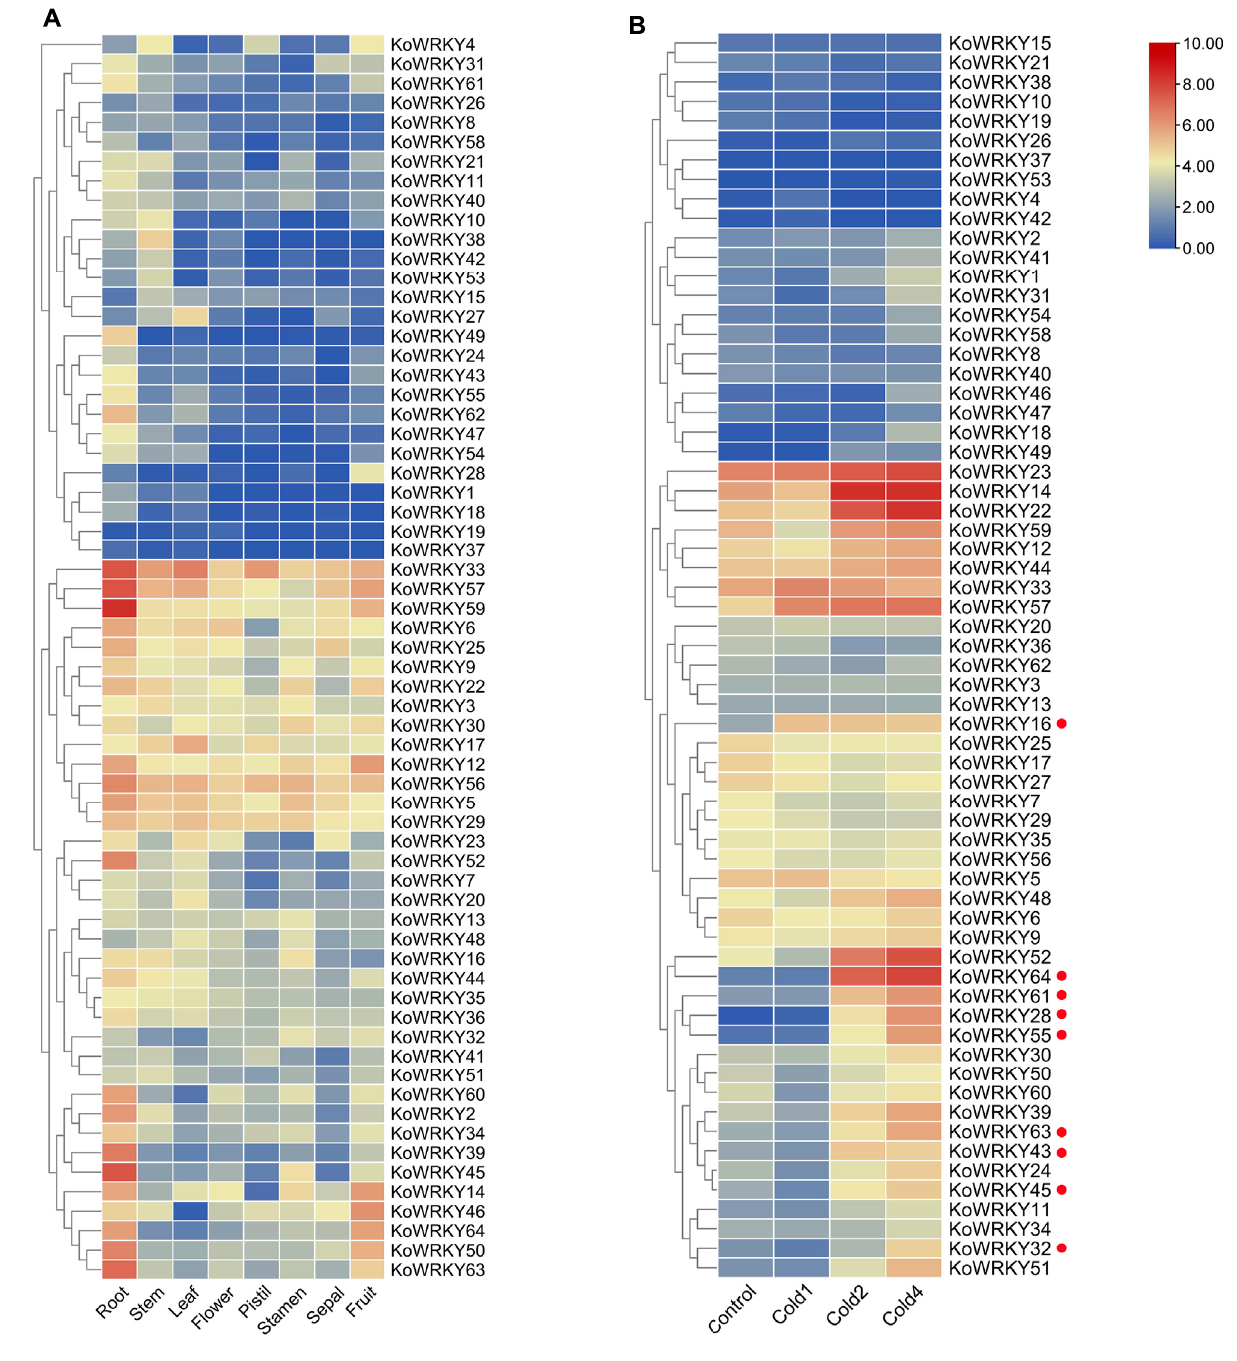
Frontiers in Genetics |